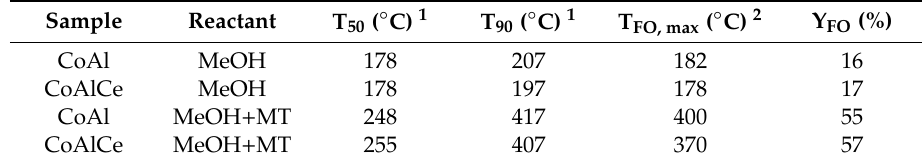
Table 5. Comparison of light-off temperature, 90% conversion temperature (T 50 and T 90 ) and formaldehyde yields in the reactions of methanol and a mixture of methanol and methanethiol over CoAl and CoAlCe catalysts.